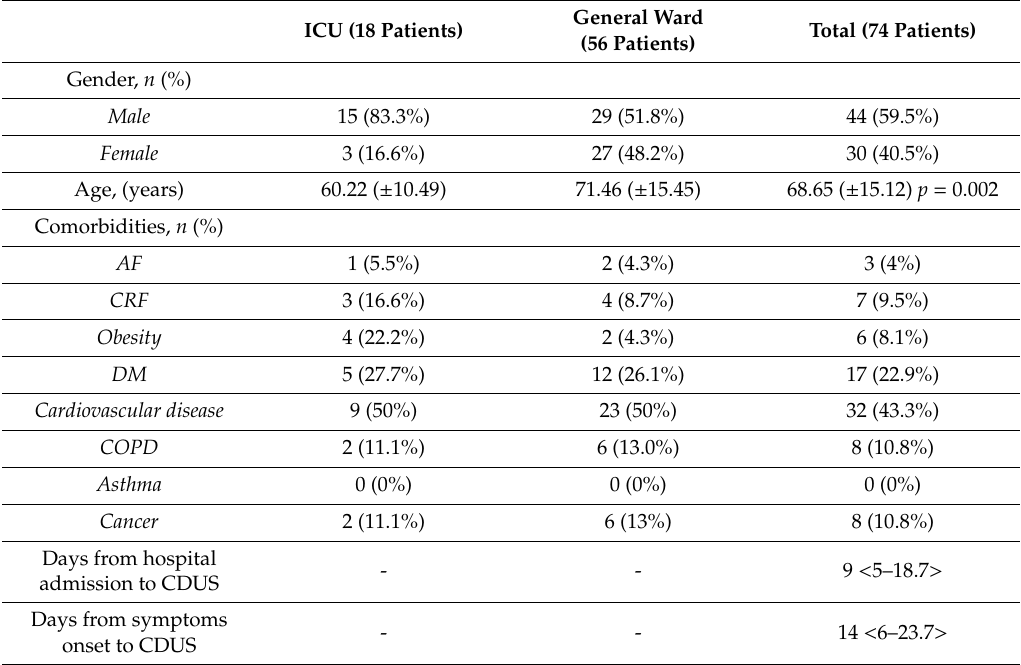
Table 1. Demographic characteristics and principal comorbidities of intensive care unit (ICU) and general ward patients. Parametric data were represented as mean (standard deviation) and non-parametric data as median < 1st, 3rd interquartile > .